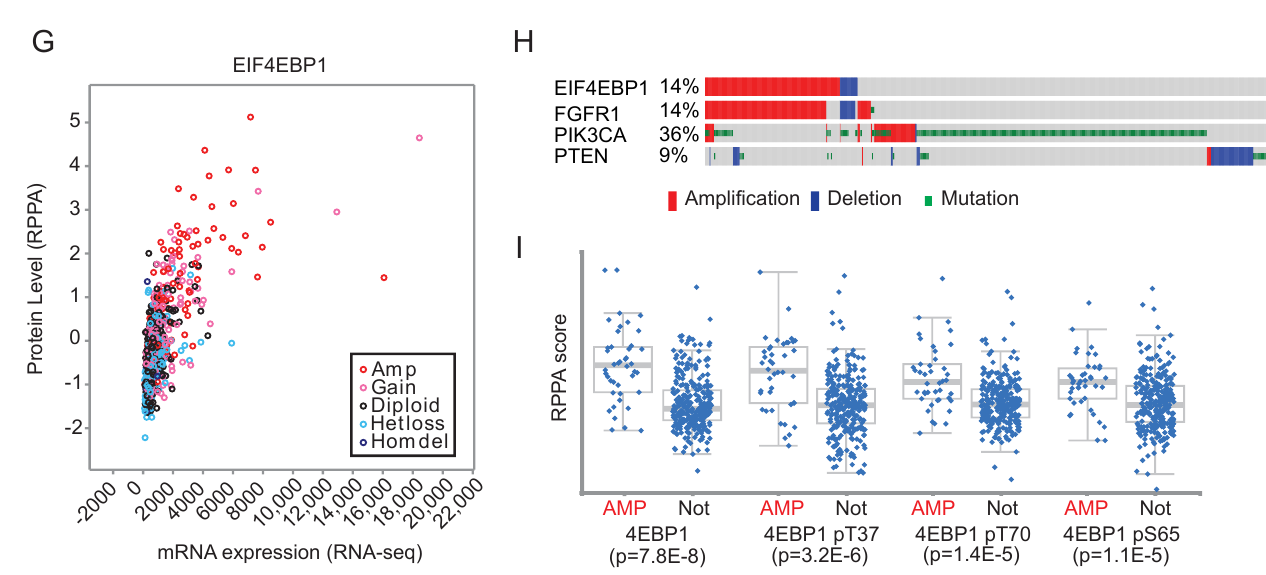
Figure 1. 4EBP1 is a target of genomic copy number gains (Chr. 8p11) in breast and lung cancer. ( A ) Visualization of Chr. 8p11-12 region amplified in human breast cancer patients (TCGA data and cbio portal data from MSKCC). Red shows the amplified region while blue is deleted. ( B ) Correlation plots show a positive correlation between 4EBP1 and FGFR1 copy numbers in breast cancer patient samples (TCGA and cBio portal data from MSKCC). ( C ) Oncoprint map showing the frequency of amplification of 4EBP1, WHSC1L1, and FGFR1 in breast cancer TCGA data classified by various subtypes. ( D ) 4EBP1- and FGFR1-amplified breast cancer patients showed poor survival compared to non-amplified cases. ( E , F ) Correlation plots show a positive correlation of mRNA expression with copy number of 4EBP1 and FGFR1 in breast cancer patient samples (TCGA and cbio portal data from MSKCC). ( G ) 4EBP1 protein expression was elevated and correlated positively with the mRNA levels in 4EBP1-amplified breast cancer patient samples. ( H ) Oncoprint map showing that 4EBP1 and FGFR1 amplification was mutually exclusive to PI3KCA and PTEN mutation in breast cancer patients. ( I ) Reverse-phase protein array (RPPA) analysis shows that a total 4EBP1, as well as phospho-4EBP1 (T37, T70 and S65) protein, was upregulated in 4EBP1- and FGFR1-amplified breast cancer, patients.